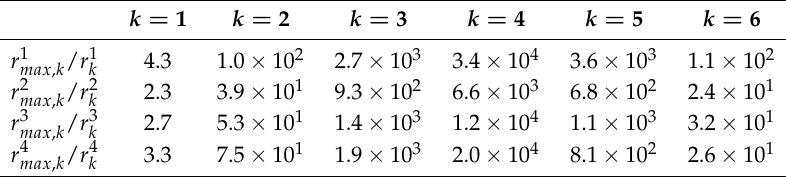
Table 2. Ratio between the theoretical maximum ranks and the TT-ranks of the outputs of interest. k =